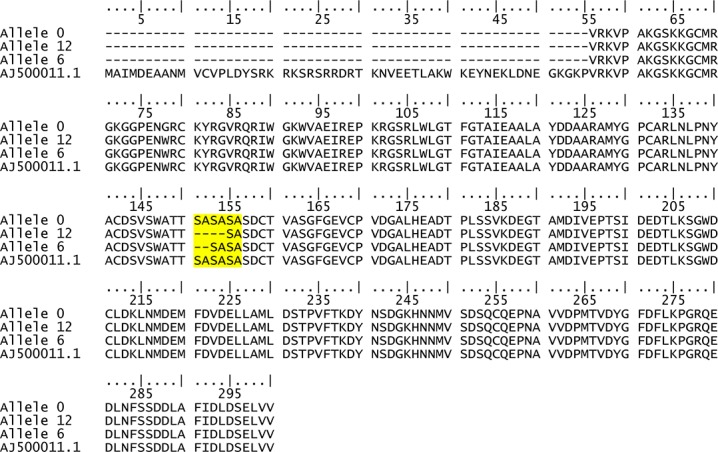
Predicted protein sequence alignment for alleles corresponding to 297 bp position in DREB1A gene identified in a panel of 94 accessions of S. pimpinellifolium along with a reference sequence of DREB1A in S. lycopersicum (AF 500011.1).The amino acid sequence variation corresponding to 297 bp is highlighted.